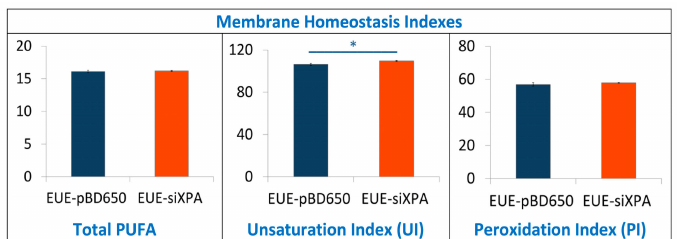
Figure 7. Membrane homeostasis indexes in EUE-pBD650 (wt) and EUE-siXPA cells. The values are given as mean ± SD ( n = 3). Values significantly di ff erent from EUE-pBD650 cells: (*) p < 0.05, For specific values see Table